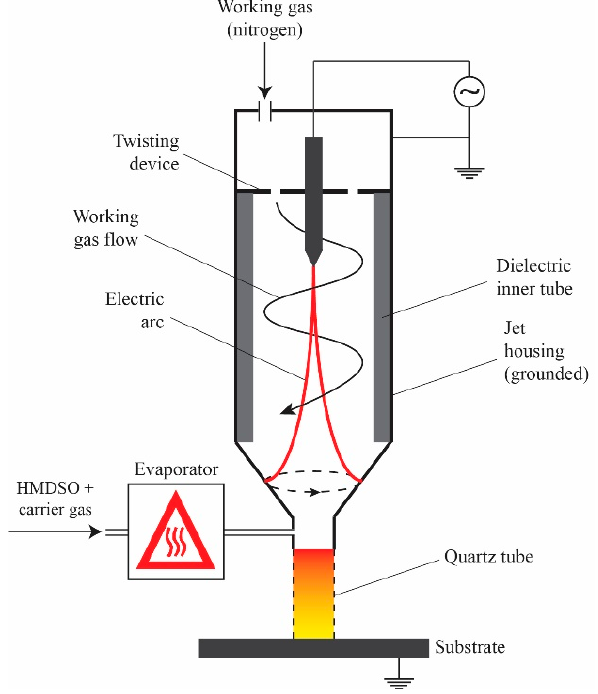
Figure 1. Schematics of the modified APPJ used in this study.